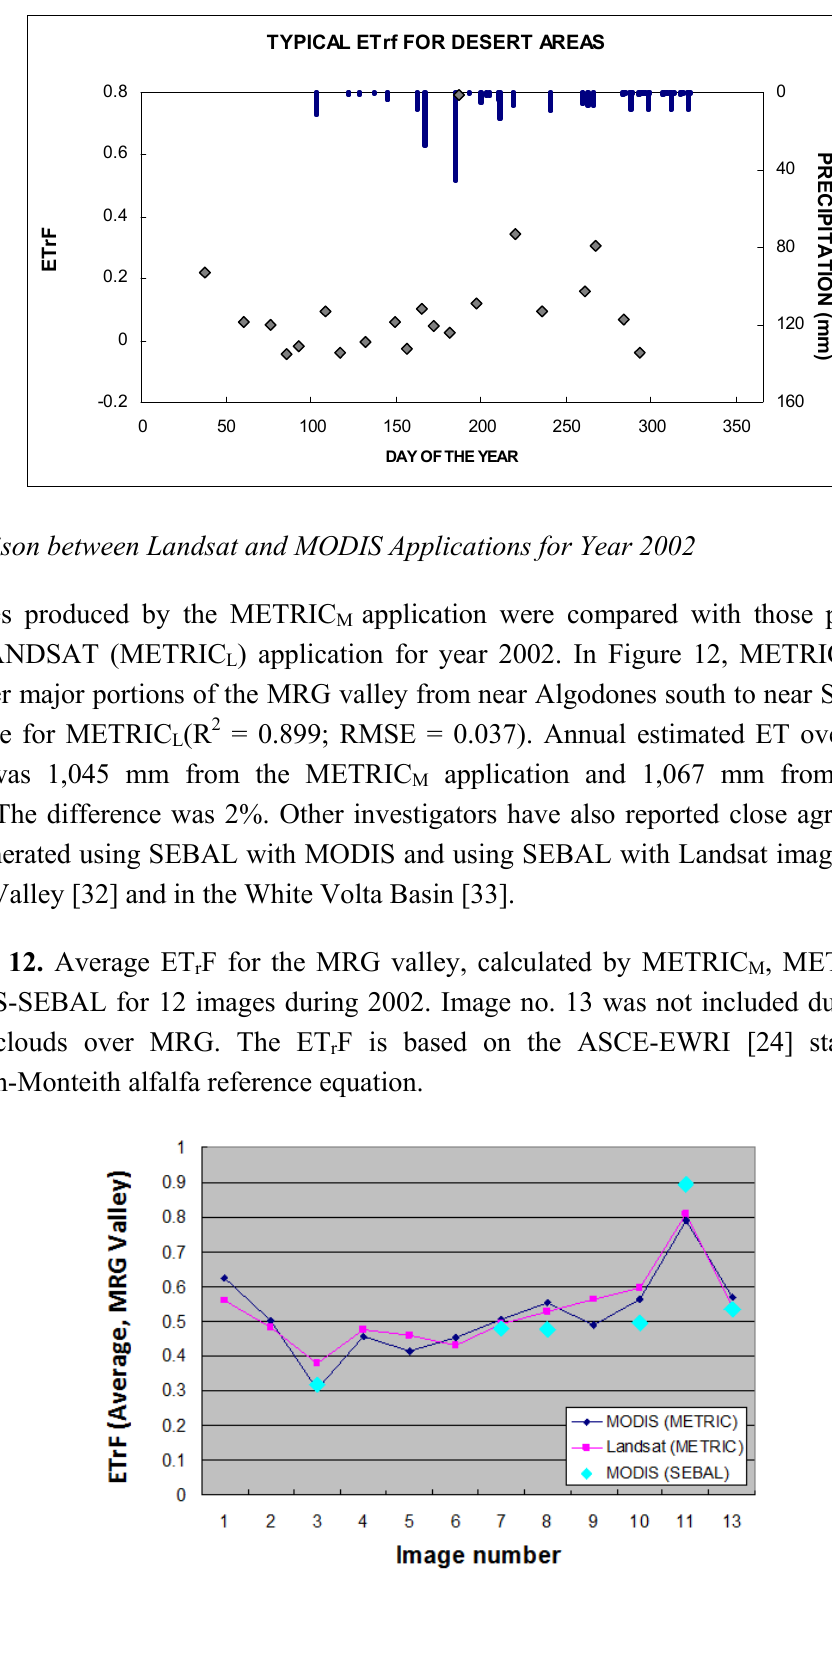
F, obtained from METRIC, from January to September 2007, Figure 11. Variation of ET r obtained by averaging several pixels in a desert area.